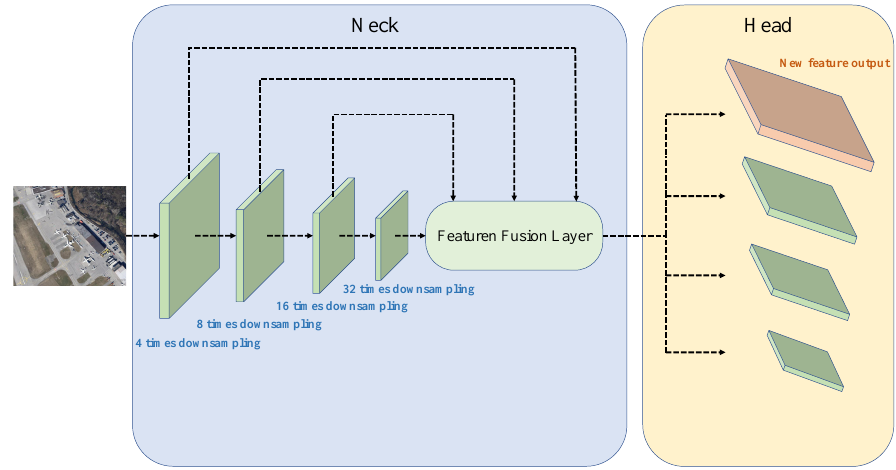
Figure 7. The new feature fusion